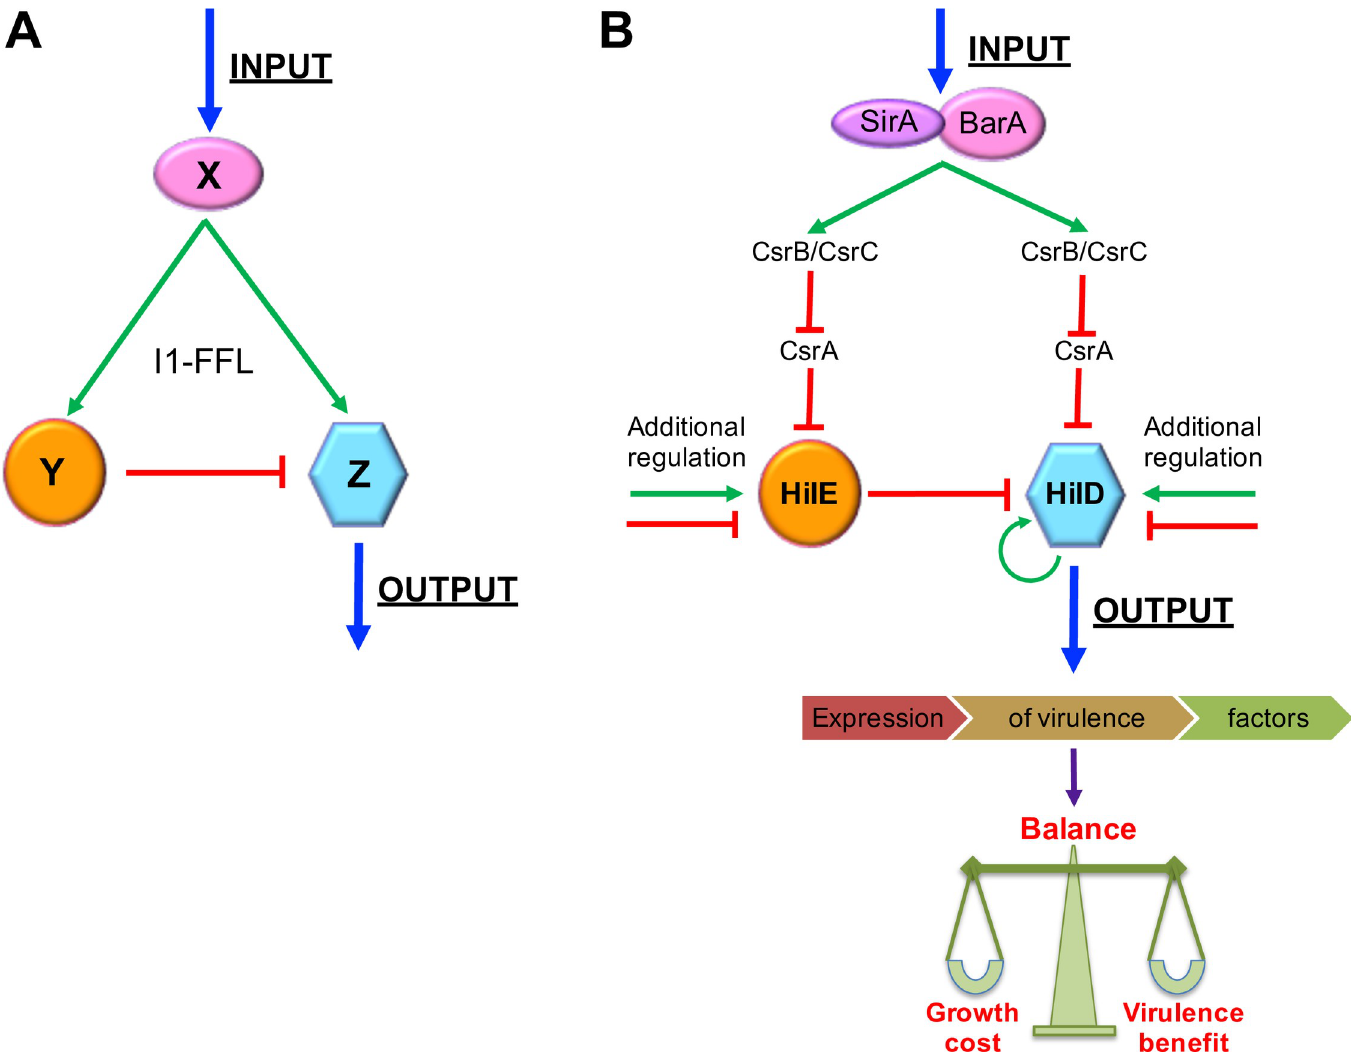
Fig 8. Structure and role of I1-FFL SirA/BarA-HilE-HilD in Salmonella virulence. (A) Structure of the incoherent type-1 feedforward loop (I1-FFL) network motif, where the factor X activates factors Z and Y, and Y represses Z; thus, X exerts opposite controls on Z. (B) Structure and function of I1-FFL SirA/BarA-HilE-HilD . Molecules present in the mammalian intestines, such as short-chain fatty acids, have been shown to activate the SirA/BarA two-component system. SirA/BarA induces expression of both HilD and HilE, through the sRNAs CsrB and CsrC, which bind to CsrA and thus counteract CsrA-mediated repression on the hilD and hilE transcripts. HilE inhibits activity of HilD by protein-protein interaction. Therefore, SirA/BarA simultaneously exerts positive and negative control on HilD, which cooperates for the appropriate balance between the growth cost and the virulence benefit generated by the expression of tens of virulence genes regulated by HilD. Additional positive and negative regulation on HilD and HilE also would control the expression level of the genes regulated by HilD. See text for more details. Green arrows and red blunt-end lines indicate positive and negative control, respectively.